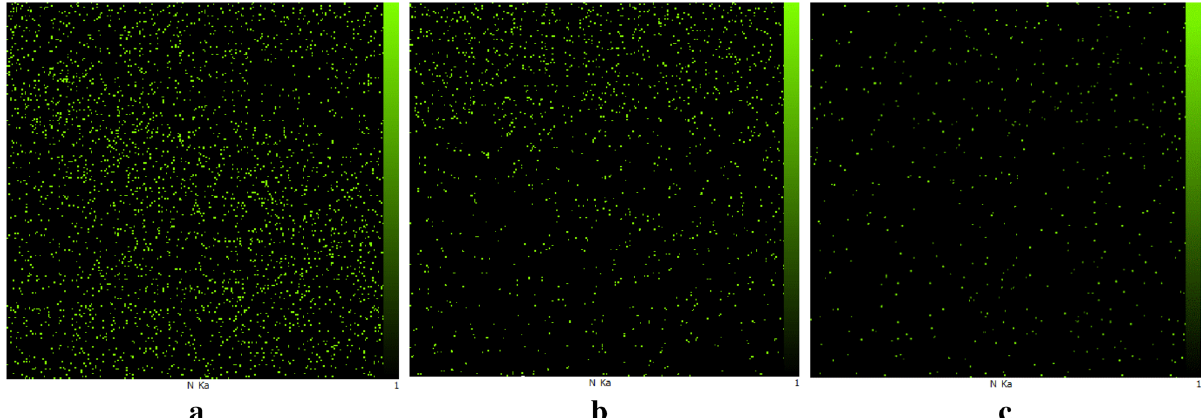
Figure 2. Energy-dispersive X-ray spectroscopy (EDX) map scanning spectra for Nitrogen element: ( a ) top surface, ( b ) cross-section and ( c ) bottom surface of SAN membrane with 25% acrylonitrile, using DMF as solvent and the polymer concentration of 8% w/w; BWB time = 300 s, bath temperature = 0 °C and film thickness = 250 µm. As can be seen, the density of nitrogen on the top surface is obviously higher than the bottom surface, which indicates the migration of acrylonitrile coil to the